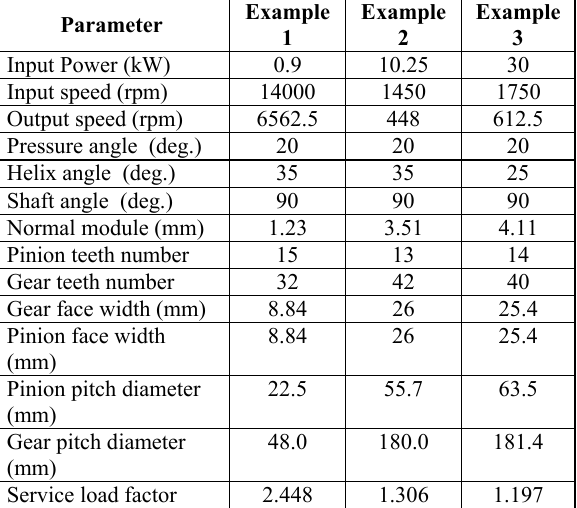
Table 1: Input Parameters for Design Cases